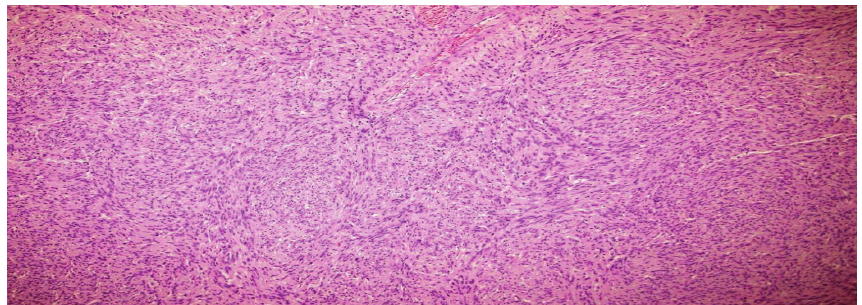
Figure 4: Schwannoma cell morphology, H&E × 200.